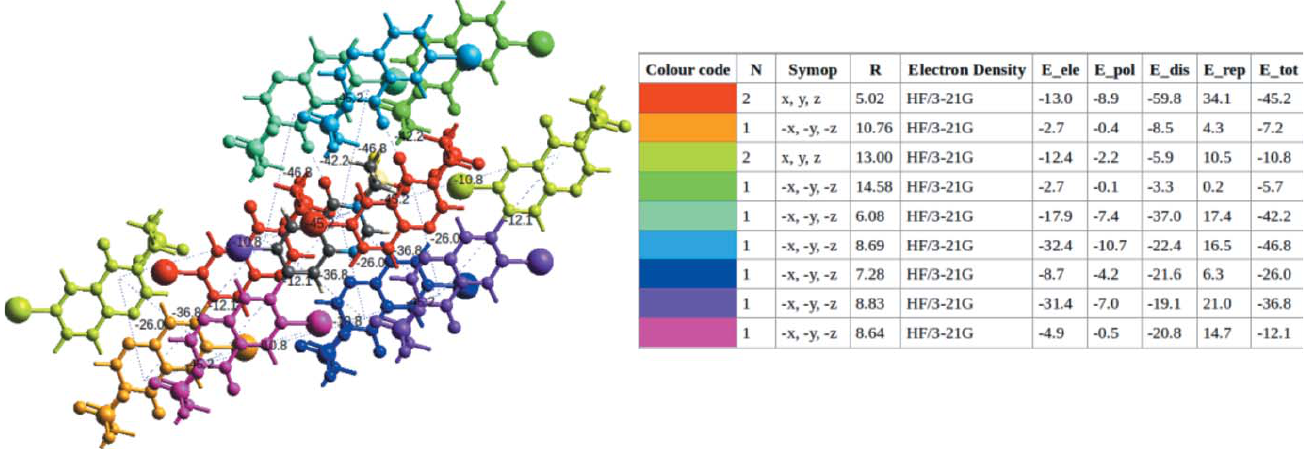
Figure 7 Intermolecular energies (in kJ mol (cid:4) 1 ) and their components in the structure of (I). N is the number of molecules in a group, Symop is the symmetry operator, R is the distance between molecular centroids in A˚